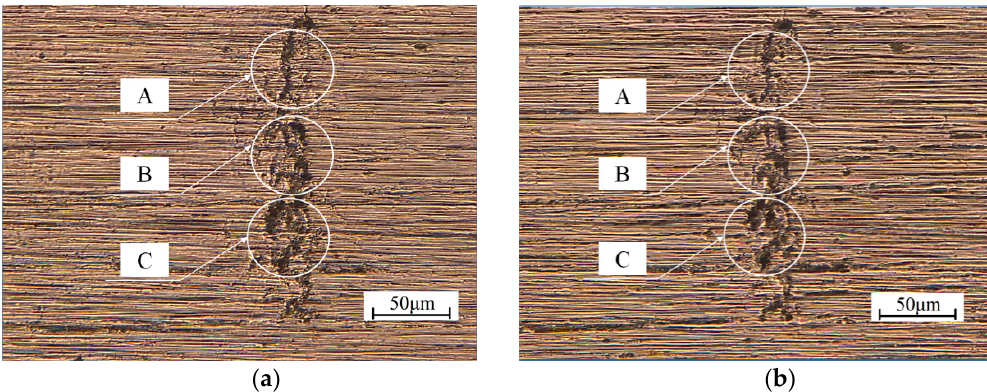
Figure 9. Crack tip of the fatigue crack in the specimen under the ±50 MPa loading level: ( a ) before EPT; ( b ) after